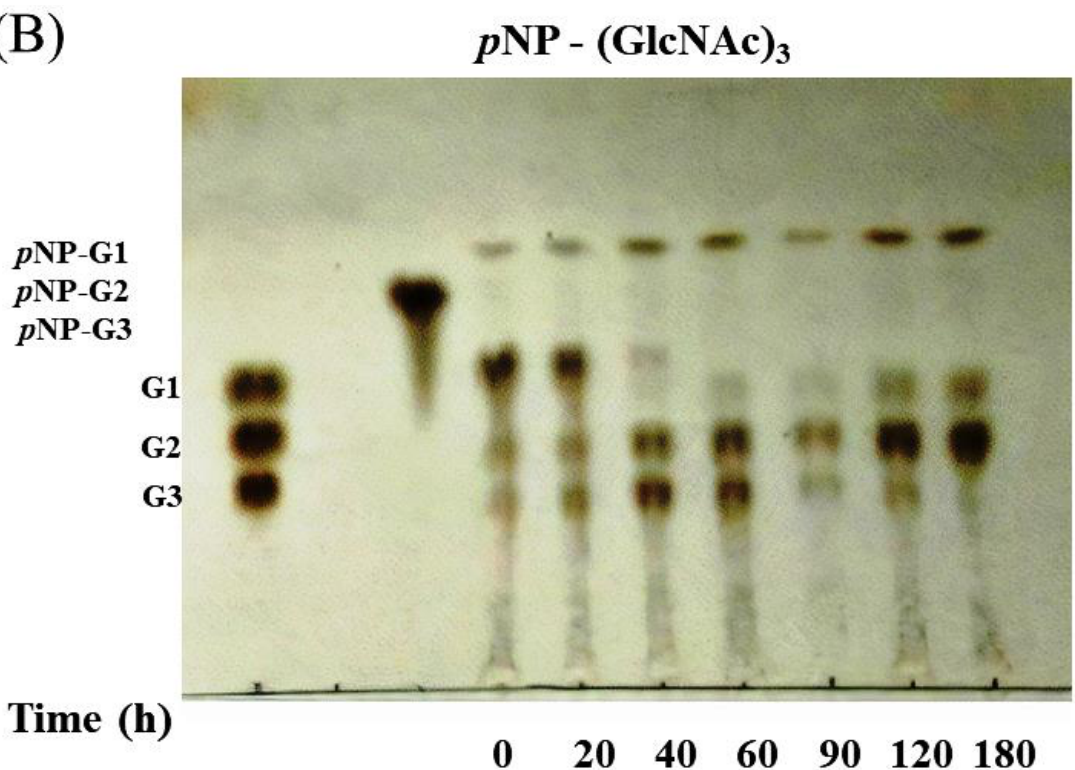
Figure 5. TLC analysis of reaction products of various p-nitrophenyl GlcNAc oligomers incubated with chitinase 1198. Reaction mixtures containing ( A ) 0.5 mg / mL of p-NP-(GlcNAc) or ( B ) p-NP(GlcNAc)2 as a substrate in 50 mM sodium phosphate bu ff er (pH = 6.5) were incubated with chitinase 1198 (0.28 M) at 40 ◦ C for the indicated times (0, 20, 40, 60, 90, 120, and 180 min). Lane M, standard GlcNAc oligomers ranging from (GlcNAc)1 to (GlcNAc)3 (G1 to G3).